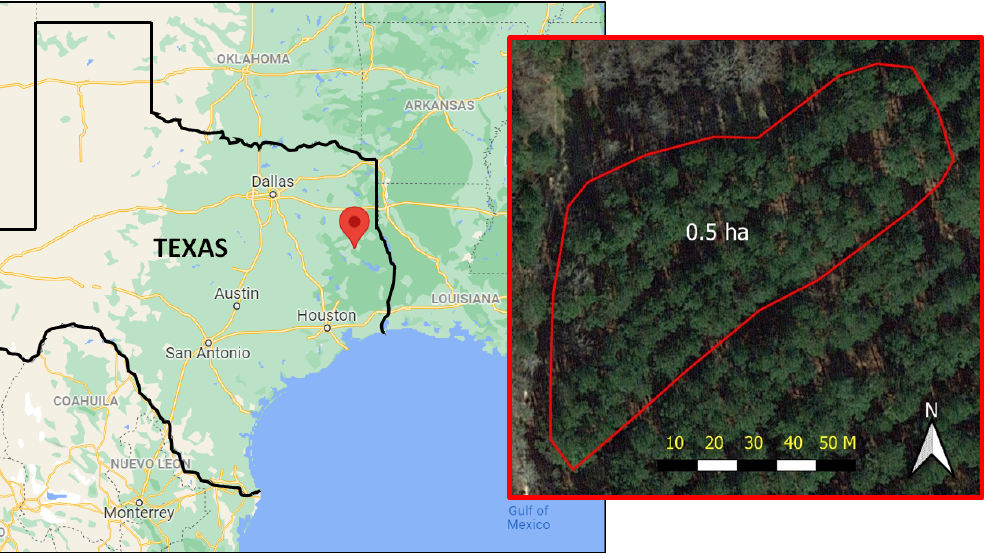
Figure 1. Study area ~44 km northwest of Nacogdoches, TX where LiDAR, field cruise, UAV imagery, and felled tree data were collected.